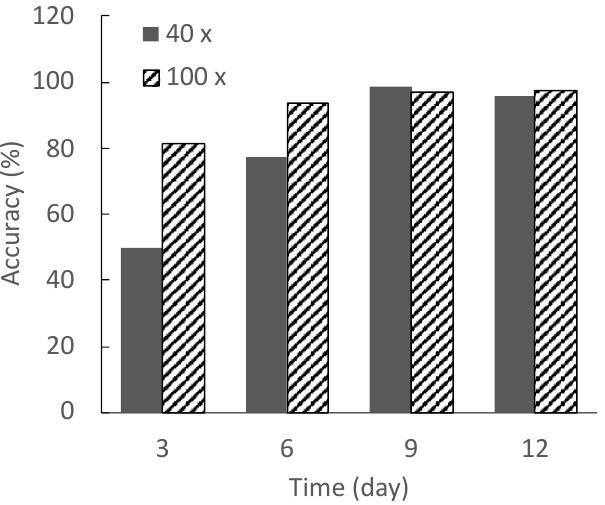
Figure 7. Discrimination accuracy of each microscopic image dataset using our CNN model.